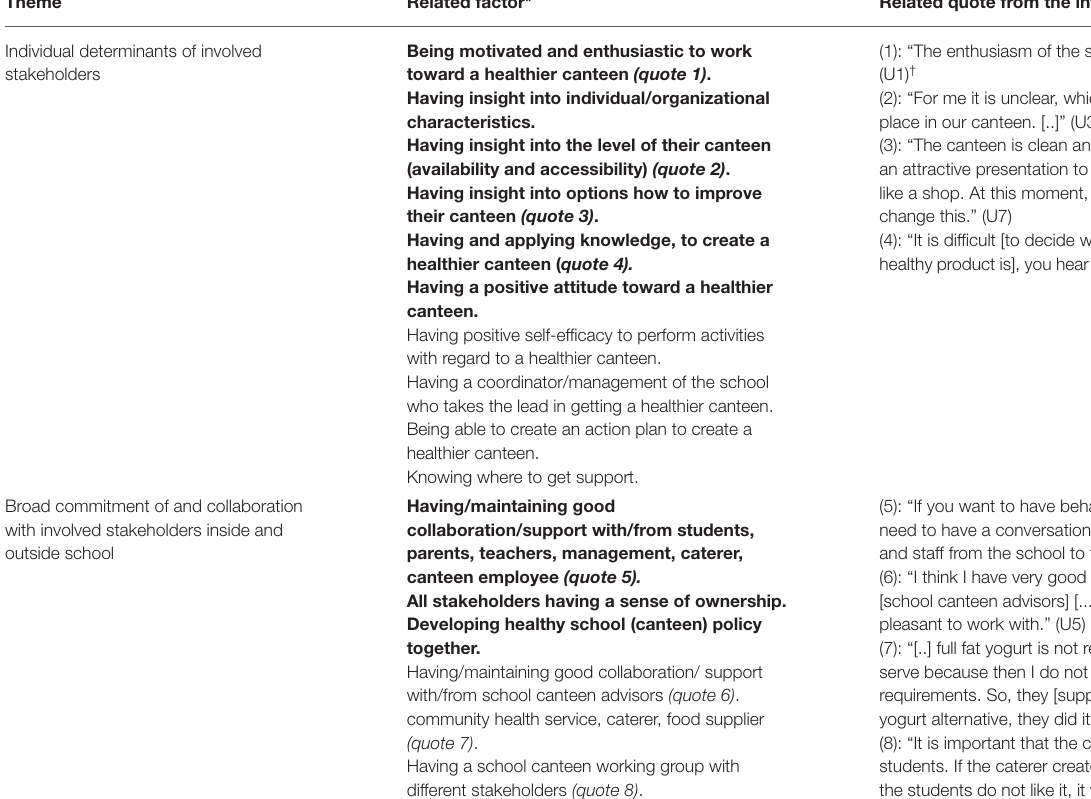
TABLE 1 | Factors and quotes identified during the interviews and prioritized during the expert meeting. Theme Related factor* Related quote from the interviews